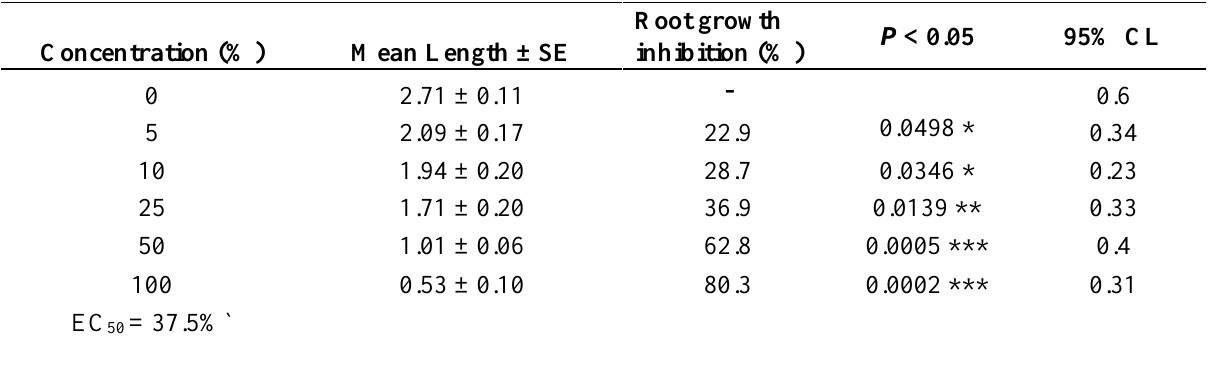
Figure 2. Macroscopic effects on Allium cepa roots exposed to E-waste leachate. ( a ) Crochet roots (10% of e-waste leachate and ( b ) C-tumor roots (50%–100% e-waste leachate). Table 2. Mean Root length of Allium cepa and % root growth inhibition at different concentrations of electronic